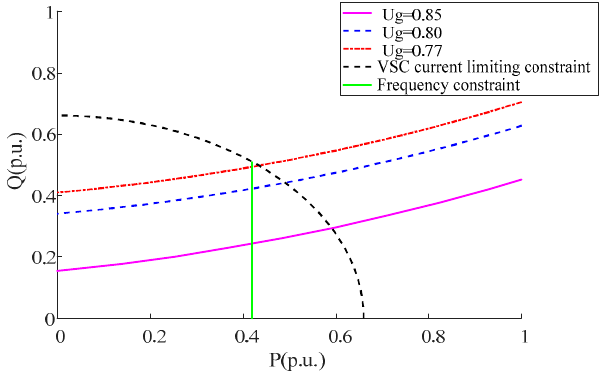
Figure 10. Variation of the controllable operation region under different voltage drops.